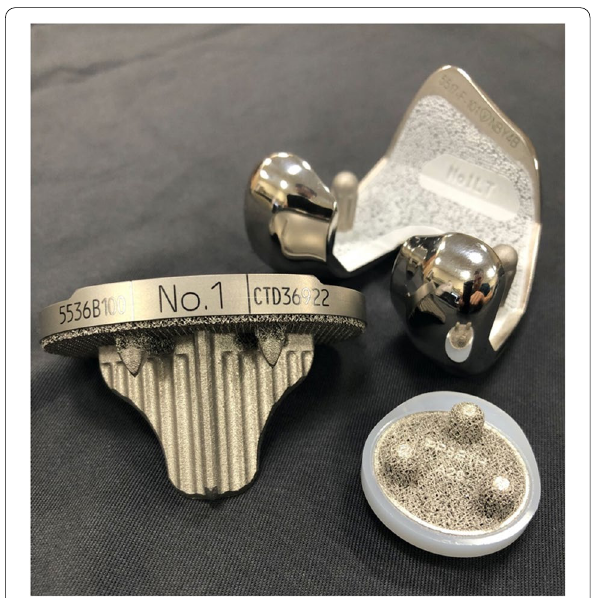
Fig. 3 Triathlon cementless